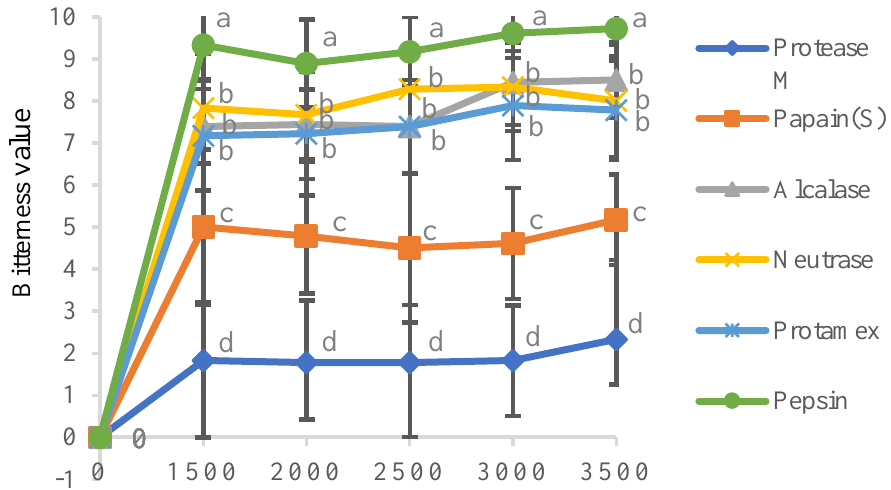
Figure 6. Bitterness values of α s1 -casein hydrolyzed by six different kinds of proteases. The different letters a–d indicate significant differences between the data.